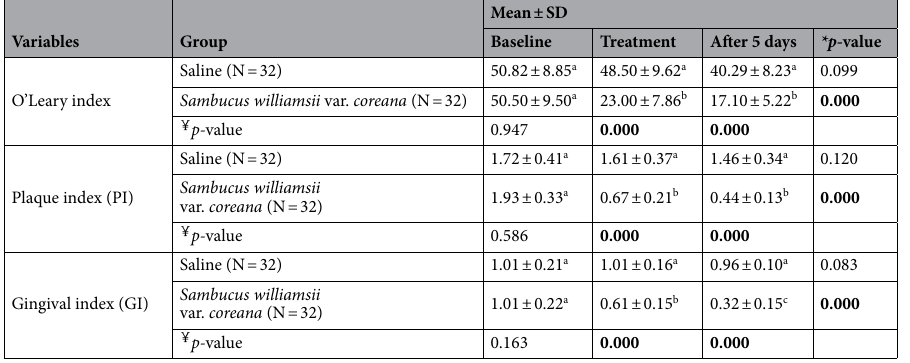
Table 2. Clinical outcomes observed between two groups. ￥ p -values are determined by independent t-test, * p -values are determined by one-way ANOVA and different letters (a, b, and c) by the presented statistically significant result of the post hoc Tukey HSD ( P < 0.05). Values are means ± standard deviations. Significant (bold).